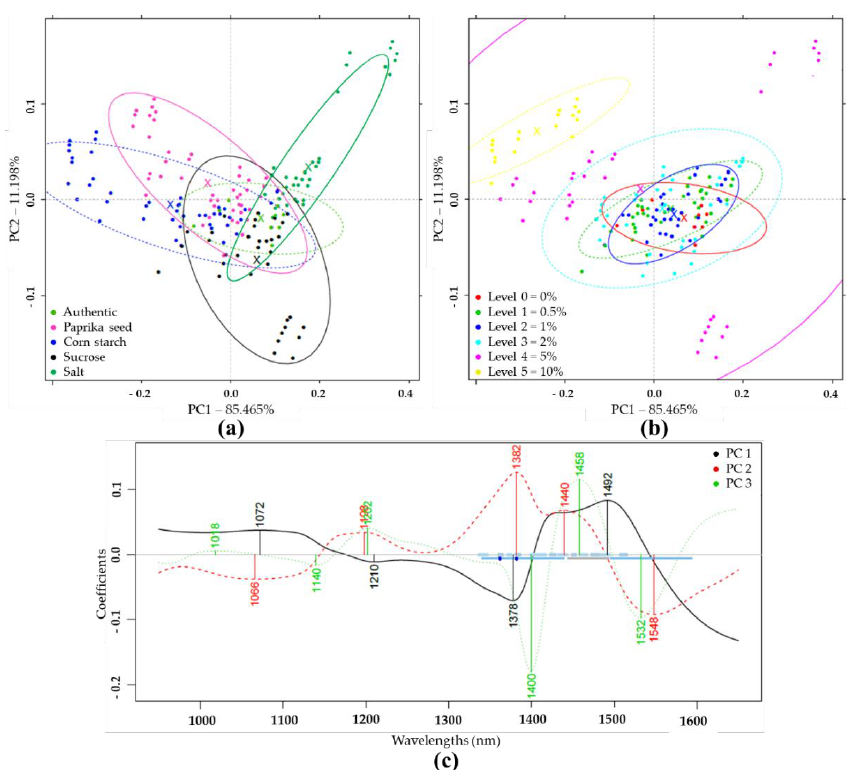
Figure 2. Principal component analysis ( PCA) on the whole Near Infrared Spectroscopy (NIRS) dataset (N = 171) in the wavelength range of 950–1650 nm, after Savitzky-Golay smoothing (SG) and multiplicative scatter correction (MSC) pretreatment of the NIRS spectra: ( a ) Score plot by adulterant type; ( b ) Score plot by adulteration level; ( c ) PCA loadings. type; ( b ) Score plot by adulteration level; ( c ) PCA